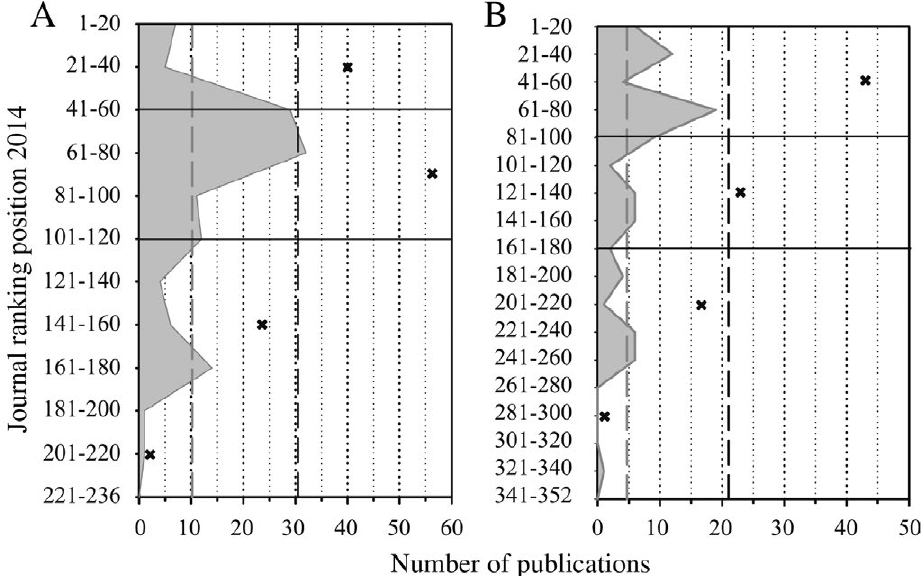
Fig. 3. – Distribution of the papers on sponge chemical (122; A) and microbial (84; B) ecology included in the subject categories Marine and Freshwater Biology , Ecology and Microbiology (only for sponge microbial ecology) as a function of the impact factor of the journals. The journals are ranked with descending impact factor (1 is the highest impact factor) and grouped in categories of 20 journals (16 and 12 in the bottom groups, respectively). Horizontal lines represent the first and the second quartile (i.e. the upper and the lower lines, respectively) of journals. Dashed grey line denotes the number of papers expected per category of 20 journals under the assumption of equal probability of publishing the 122 and 84 papers in any journal category. Dashed black line represents the number of papers expected per quartile under the assumption of equal probability of publishing in any of the four quartiles. Crosses are the number of papers in each quartile. Table 3. – Number of papers (n), percentage of total papers on sponge chemical and microbial ecology (231 and 131, respectively; %), and cumulative percentage (cum) in the top 10 journals publishing on these research areas according to the Web of Knowledge (Thomson and Reuters 2014); * Journals that do not belong to the Marine and Freshwater Biology , Ecology and Microbiology subject categories.